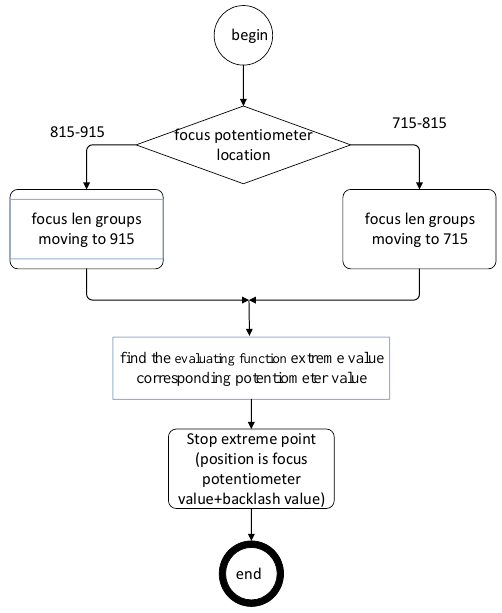
Figure 12. Auto focus algorithm flow chart.